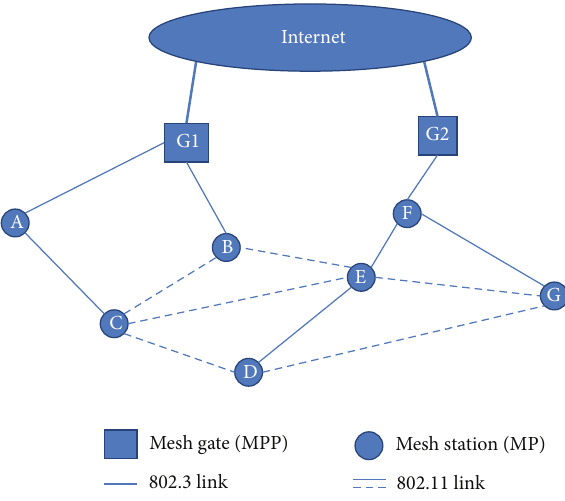
Figure 2: Wireless mesh network